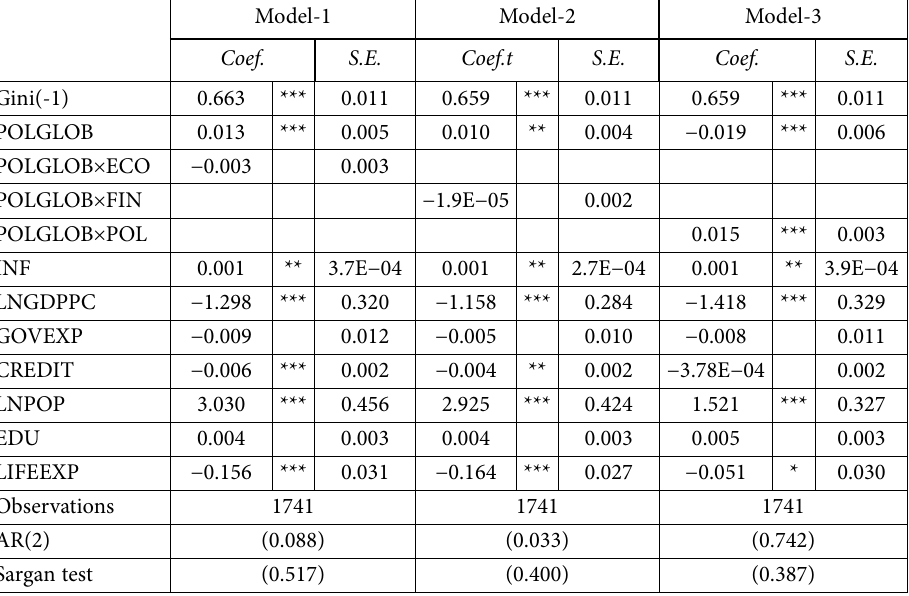
Table 5. The effects of political globalization under separate aspects of country risk